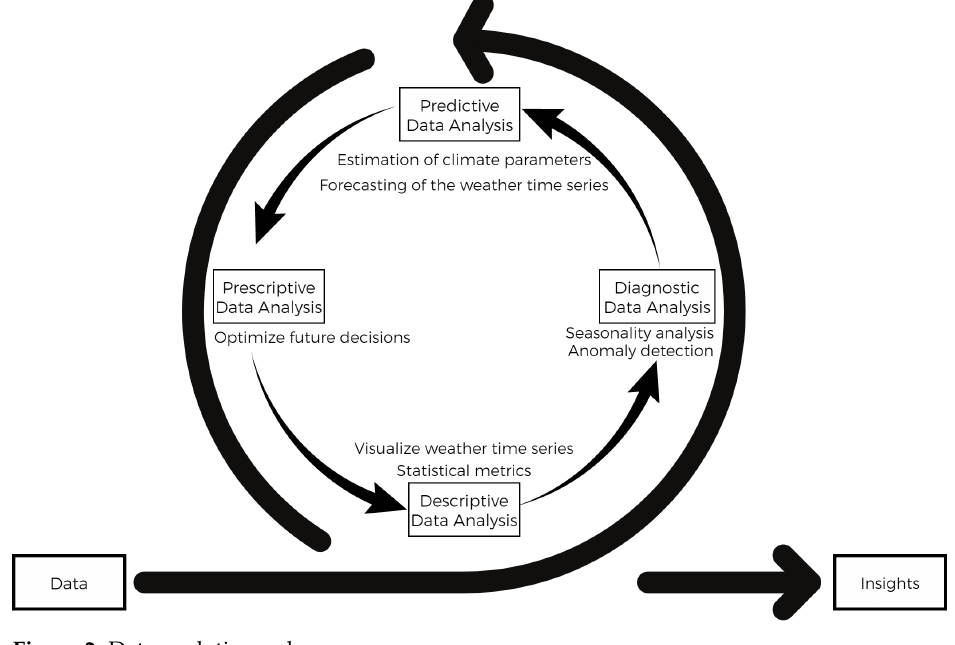
Figure 2. Data analytics